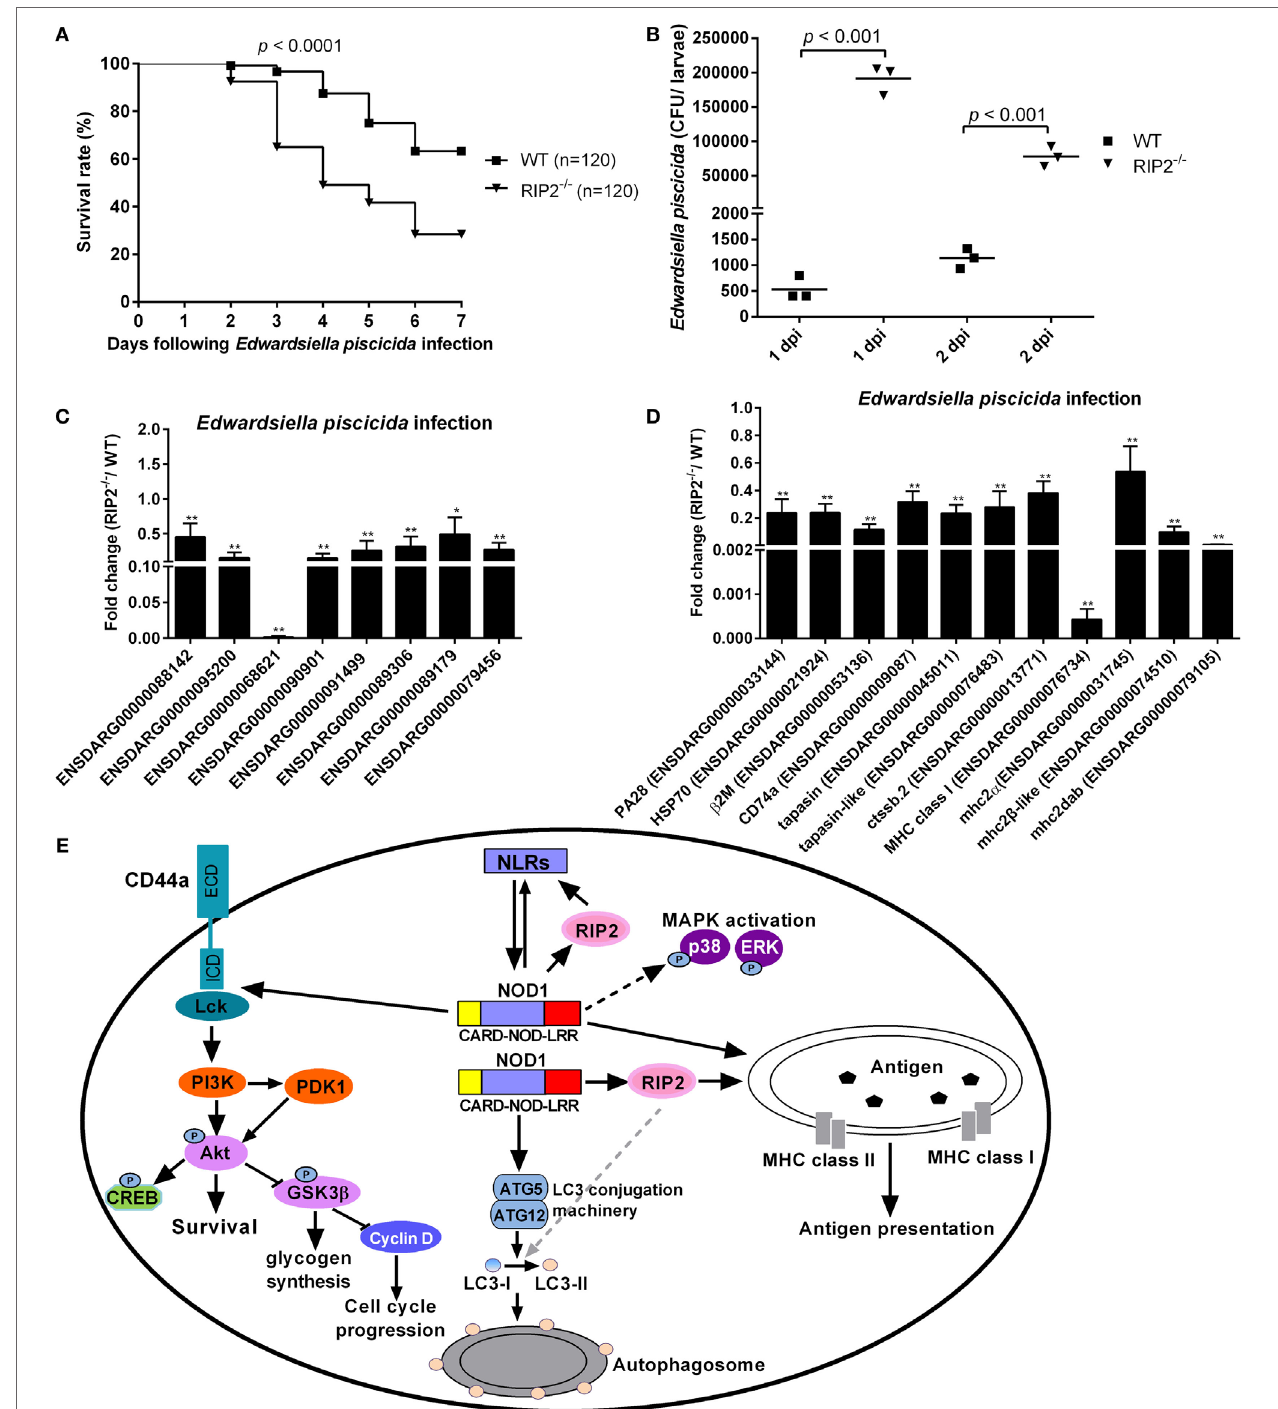
FigUre 8 | RIP2 is critical for Edwardsiella piscicida infection. (a) Survival of WT and RIP2 − / − zebrafish exposed to E. piscicida by static immersion. Zebrafish larvae at 5 days post-fertilization (dpf) were exposed to 2 × 10 8 CFU/mL E. piscicida for 6 h, and monitored for 7 days. (B) Bacterial loads in the WT and RIP2 − / − larvae at 1 and 2 dpi. Larvae from WT and RIP2 − / − zebrafish were harvested, homogenized, and plated onto TSB agar for enumeration of CFU. (c) The effect of RIP2 deficiency on the expression of NLRs during E. piscicida infection. (D) The effect of RIP2 deficiency on the expression of those genes involved in MHC antigen presentation during E. piscicida infection. For (c,D) , the hatched larvae (5 dpf) from WT and RIP2 − / − zebrafish were exposed to 2 × 10 8 CFU/mL E. piscicida in a total volume of 5 mL. After immersion in the bacterial suspension for 6 h, zebrafish larvae were maintained in 60 mm sterile disposable petri dishes with supplemental 25 mL fresh egg water. Larvae from WT and RIP2 − / − zebrafish were harvested at 48 hpi and used for qPCR. Data represent the mean ± the SEM. * p < 0.05, ** p < 0.01. (e) Proposed model illustrating the intracellular signaling pathways modulated by NOD1-RIP2 axis during zebrafish larval development at homeostasis.